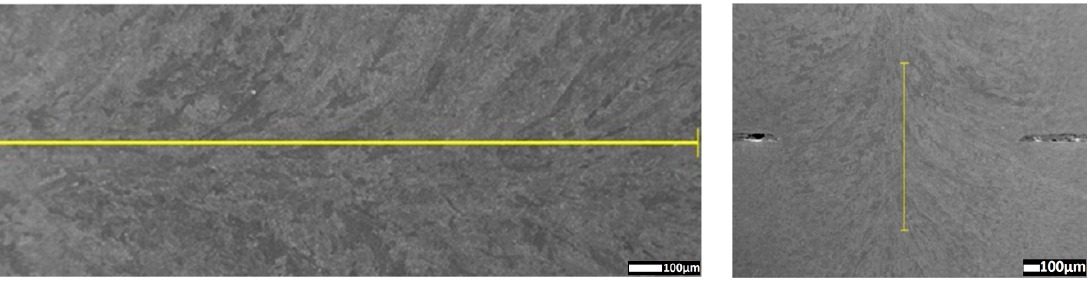
Figure 18. Measure line of fusion zone in overlap transition.